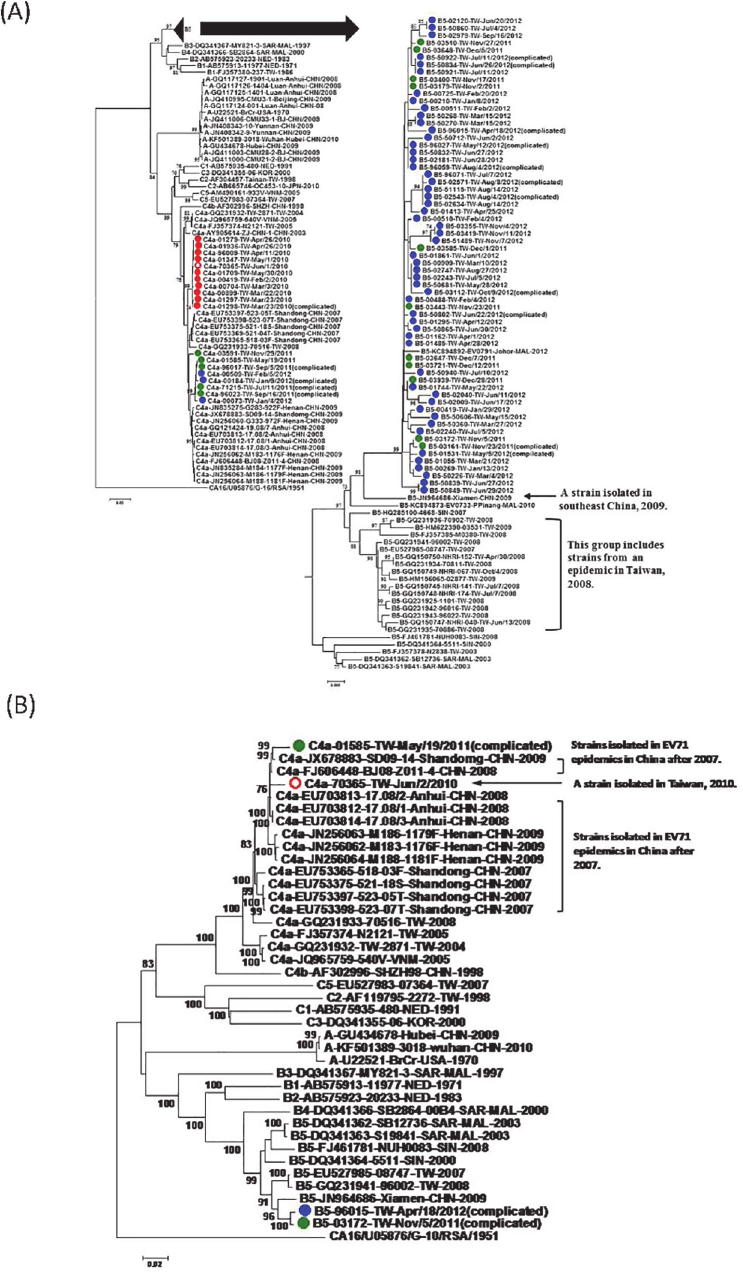
Fig 2. Phylogenetic analysis of VP1 gene (A) and full genomes (B) of EV71 virus. The phylogenetic trees were generated by the neighbor-joining method with 1000 bootstraps for EV71 isolates from this study and other published EV71 strains based on VP1 gene (891bp) and complete genome. Only bootstrap values over 70% were shown. Coxsackievirus A16 was used as the outlier. Sequences of EV71 strains isolated from this study in 2010, 2011 and 2012 were labeled with red, green and blue dots, respectively. A sequence of EV71 isolate from an outpatient in 2010 was labeled with red circle. Sequences of those EV71 strains generated in this study have been submitted to GenBank (accession codes KF154285-KF154347, KF154349-KF154356, KF933353, KP113681-KP113692).